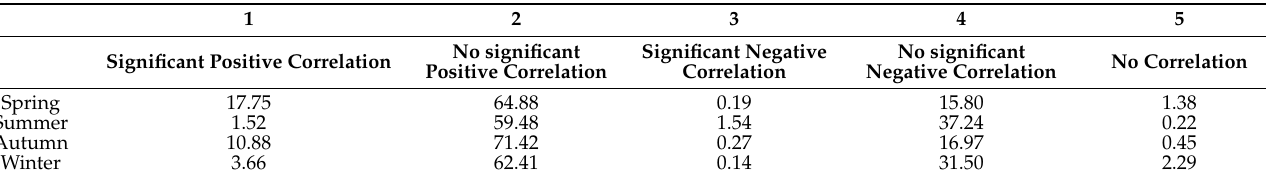
Table 11. Area proportion of correlation level between FVC and TEM /%.